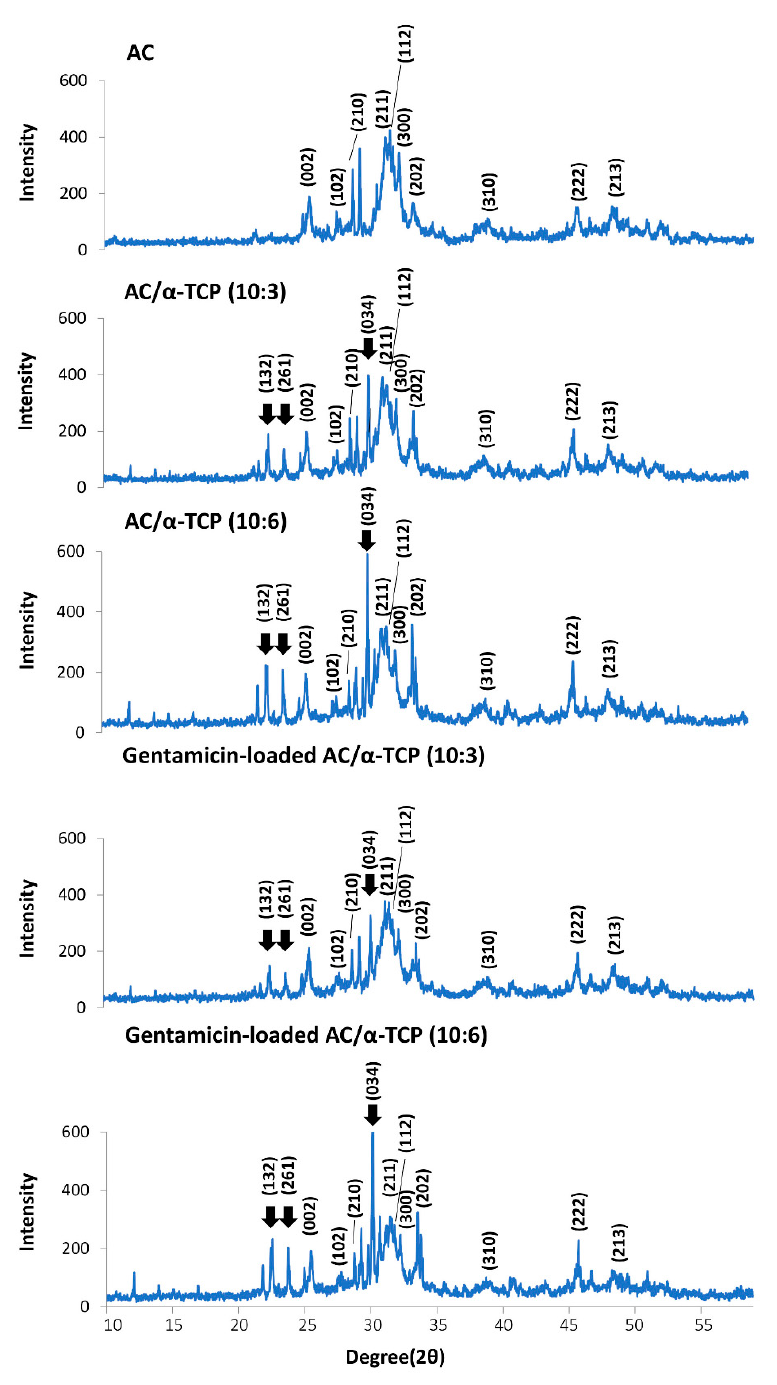
Figure 4. Powder X-ray diffraction patterns of the AC/ α -TCP and gentamicin-loaded AC/ α -TCP composites. Peaks of hydroxyapatite at 25.9 ◦ , 28.3 ◦ , 29.3 ◦ , 31.8 ◦ , 32.2 ◦ , 32.9 ◦ , 34.0 ◦ , 39.8 ◦ , 46.7 ◦ , and 49.5 ◦ were indexed as (002), (102), (210), (211), (112), (300), (202), (310), (222), and (213), respectively. Peaks of α -TCP at 22.8 ◦ , 24.2 ◦ , and 30.7 ◦ were indexed as (132), (261), and (034), respectively. (arrow). 3.4. Antimicrobial Release of the Gentamicin-Loaded AC/ α -TCP Composites Standard curve for gentamicin concentrations versus the diameters of the inhibition zone are shown in Figure 5. The minimum inhibitory concentration (MIC) of gentamicin was 2.0 µg/mL. Next, the concentrations of gentamicin released from gentamicin-loaded AC/ α -TCP composites were calculated using a standard curve. The release of gentamicin